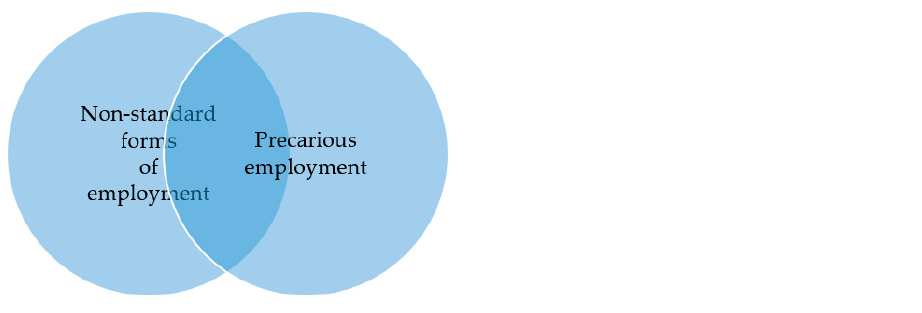
Figure 2. The correlation between non-standard forms of employment and precarious employ- ment.